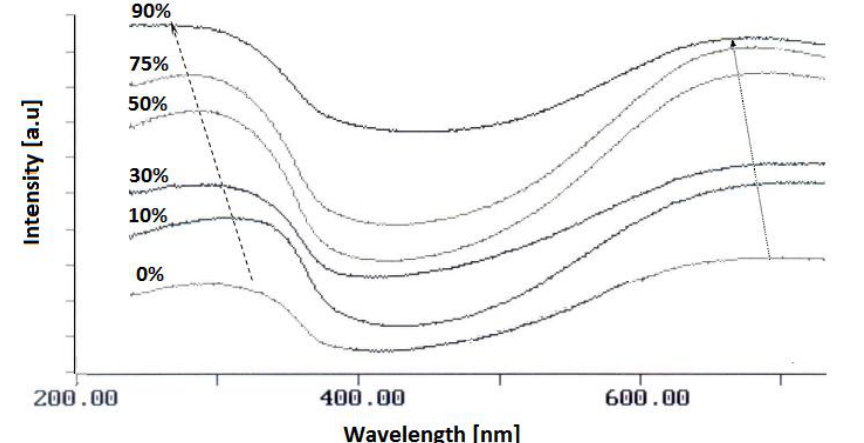
/PANi nanocomposites with different TiO 2